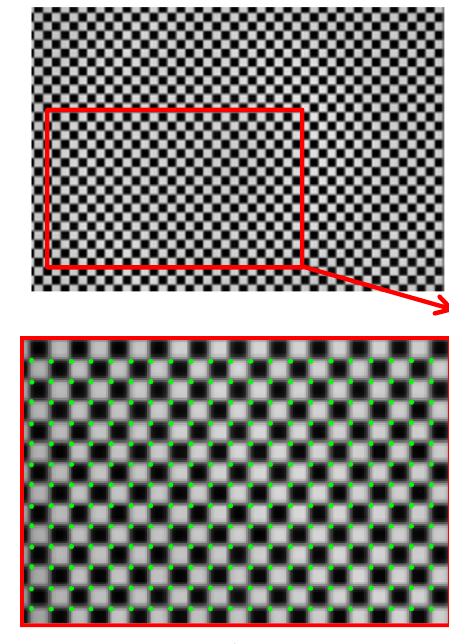
Figure 12. ( a ) Distorted image and its partial enlargement; ( b ) corrected image and its partial enlargement.